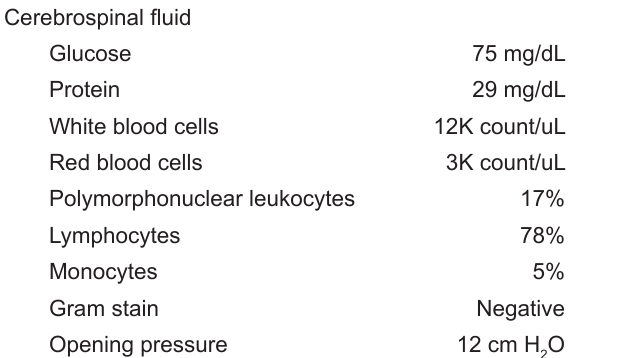
Table 4. Cerebrospinal fluid